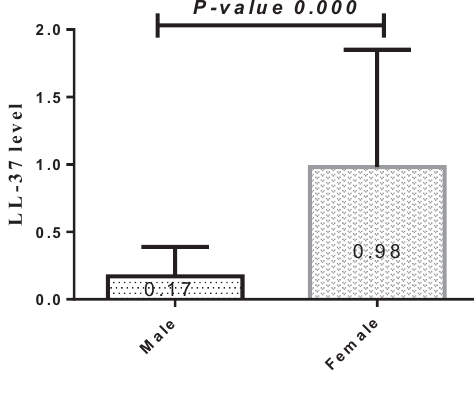
Figure 4: Mean of LL-37 across